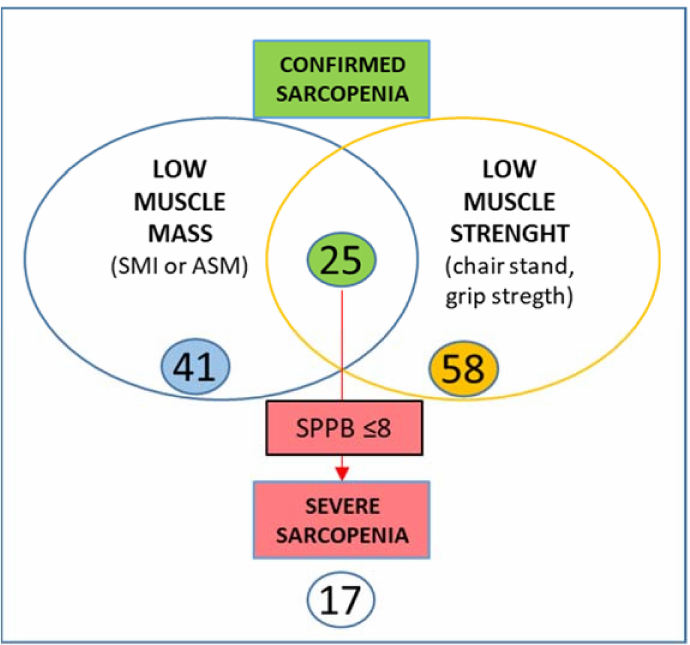
Figure 1. Prevalence of sarcopenia according EWGSOP2 definition [16]. SMI = =Skeletal Muscle Index; ASM = Appendicular Skeletal Muscle mass; SPPB = Short Physical Performance